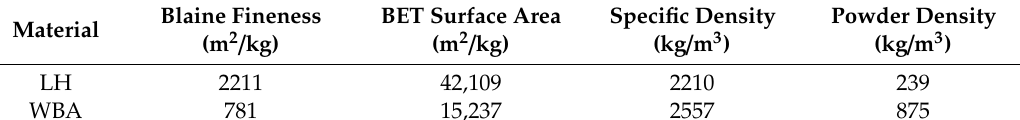
Table 4. Physical parameters of WBA and lime hydrate (LH). BET: Brunauer–Emmett–Teller.